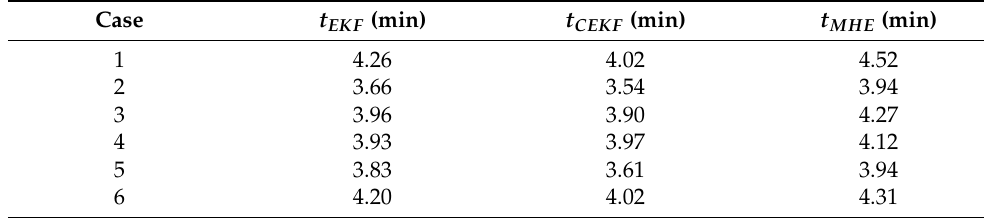
Table 6. Time spent to run each simulation for the three